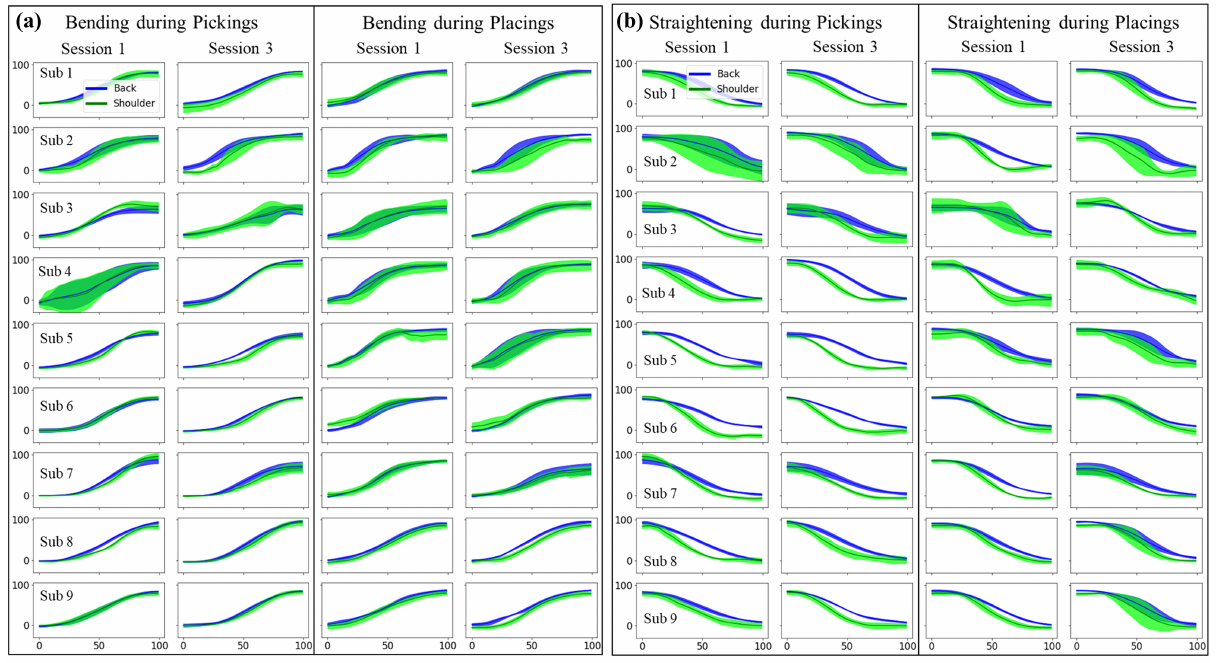
Figure 4. Visual comparison of the back inclination and shoulder flexion angles during ( a ) bending and ( b ) straining in the first and last sessions for the nine participants. The angles are shown with their mean and standard